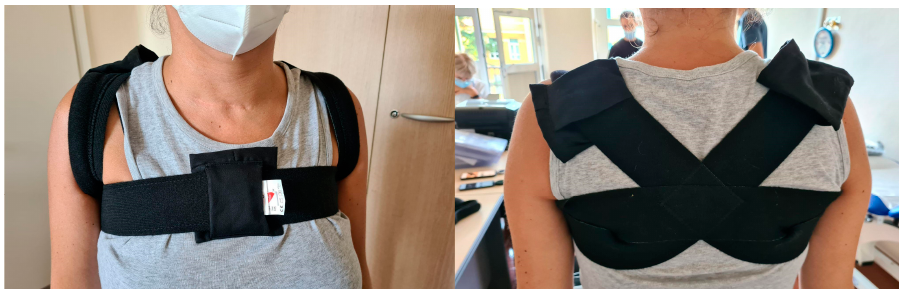
Figure 6. First smart harness solution positioning SWs on shoulders and chest.